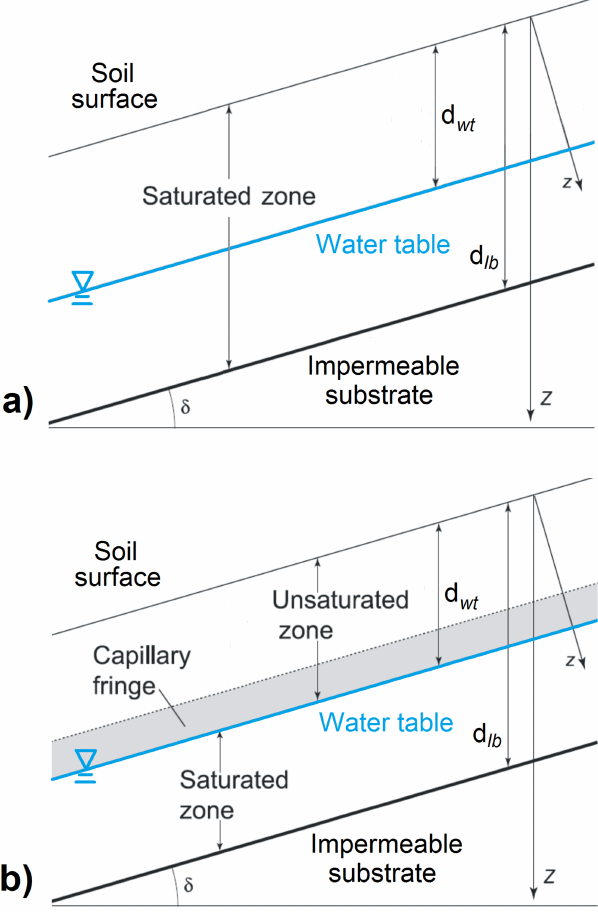
Figure 6. Conceptual sketch of the hydrological model in TRIGRS simulating tension-saturated (a) and unsaturated (b) soil conditions (modified from Baum et al.,